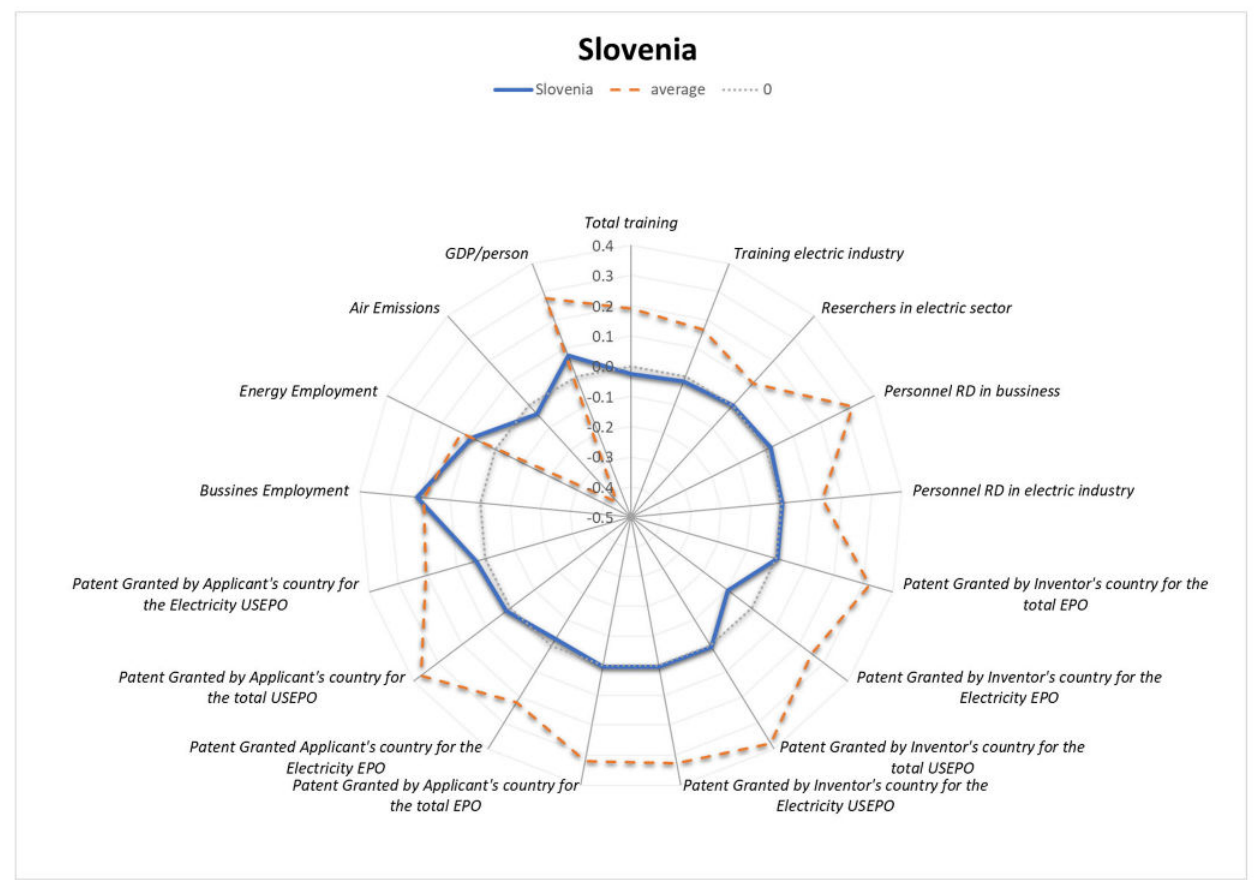
Figure 33. Synergy and trade-off occurrence—SL. Source: Authors’